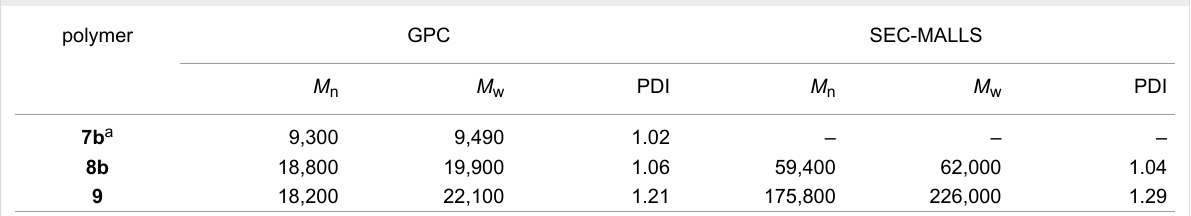
Table 1: Molecular weight analyses of the dendronized polystyrenes.